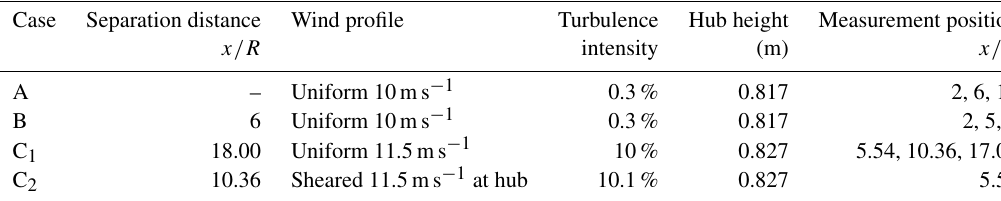
Figure 1. Illustration of wind tunnel layout for (a) the set-up with one model wind turbine (case A) and (b) the set-up with two in-line model wind turbines (case B). The three downstream positions x/R = 2, 6, 10 and x/R = 2, 5, 8 are where the measurements are extracted; radius R = 0 . 447m. Table 1. Overview of